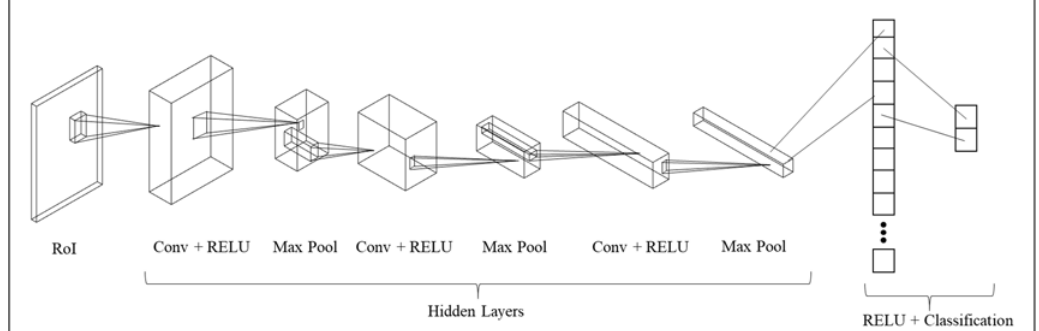
Figure 22. Architecture of the CNN-based binary classi fi cation mode used for comparison purposes.